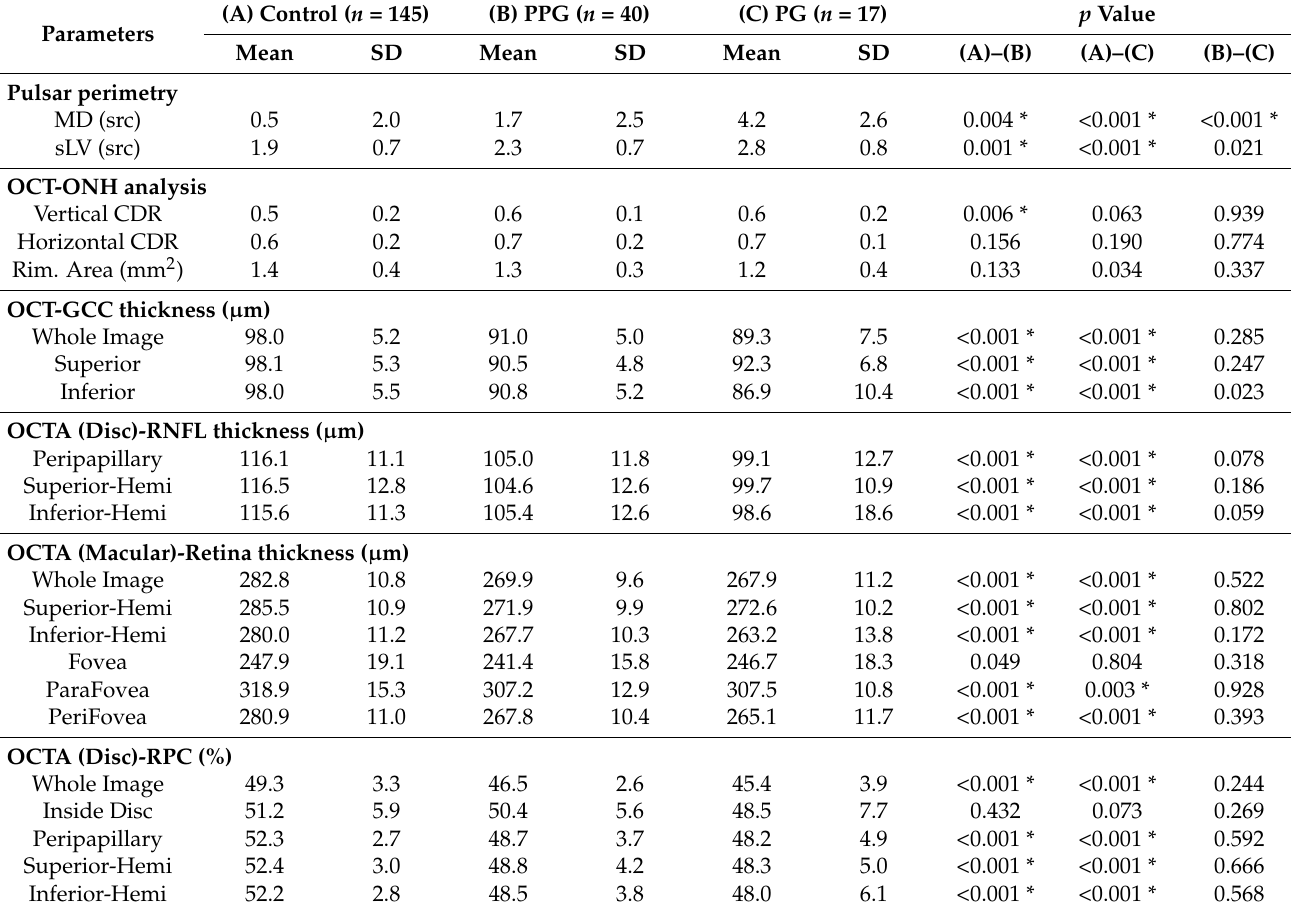
Table 2. Comparison of each parameter measured with Pulsar perimetry, OCT, and